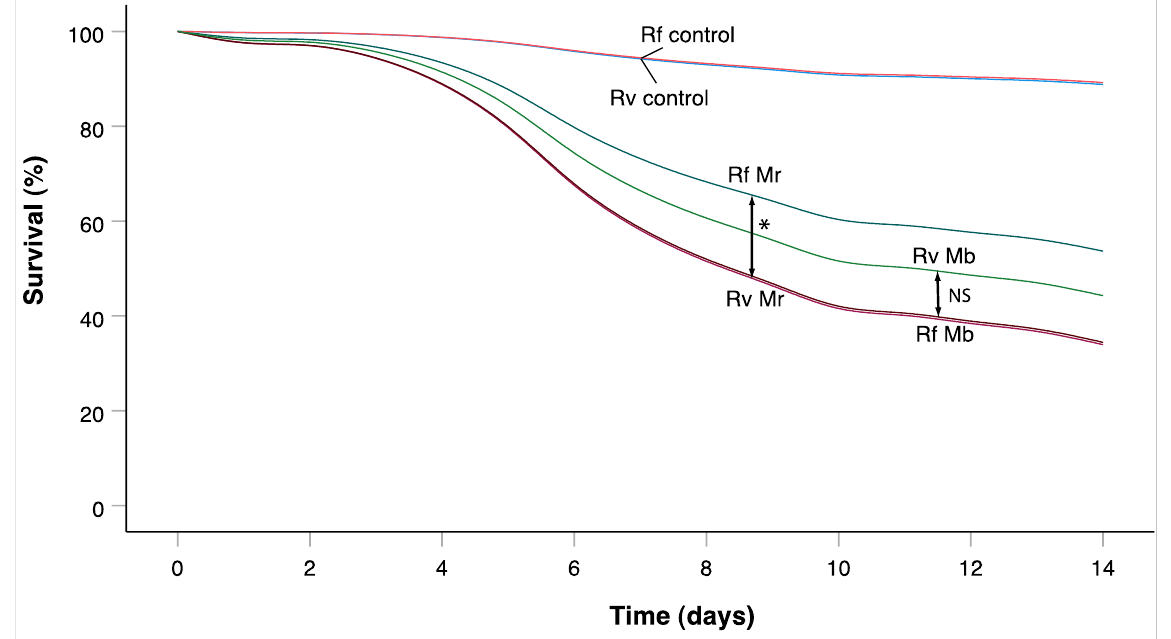
Figure 1. Survivorship for groups of 12. Rf corresponds with R. flavipes , Rv with R. virginicus , Mr with M. robertsii and Mb with M. brunneum . Significant survival differences for pairwise comparisons were based on Breslow tests (generalized Wilcoxon tests). * Significant difference between treatments, NS no significant difference between treatments ( p < 0.025 Bonferroni adjusted α).